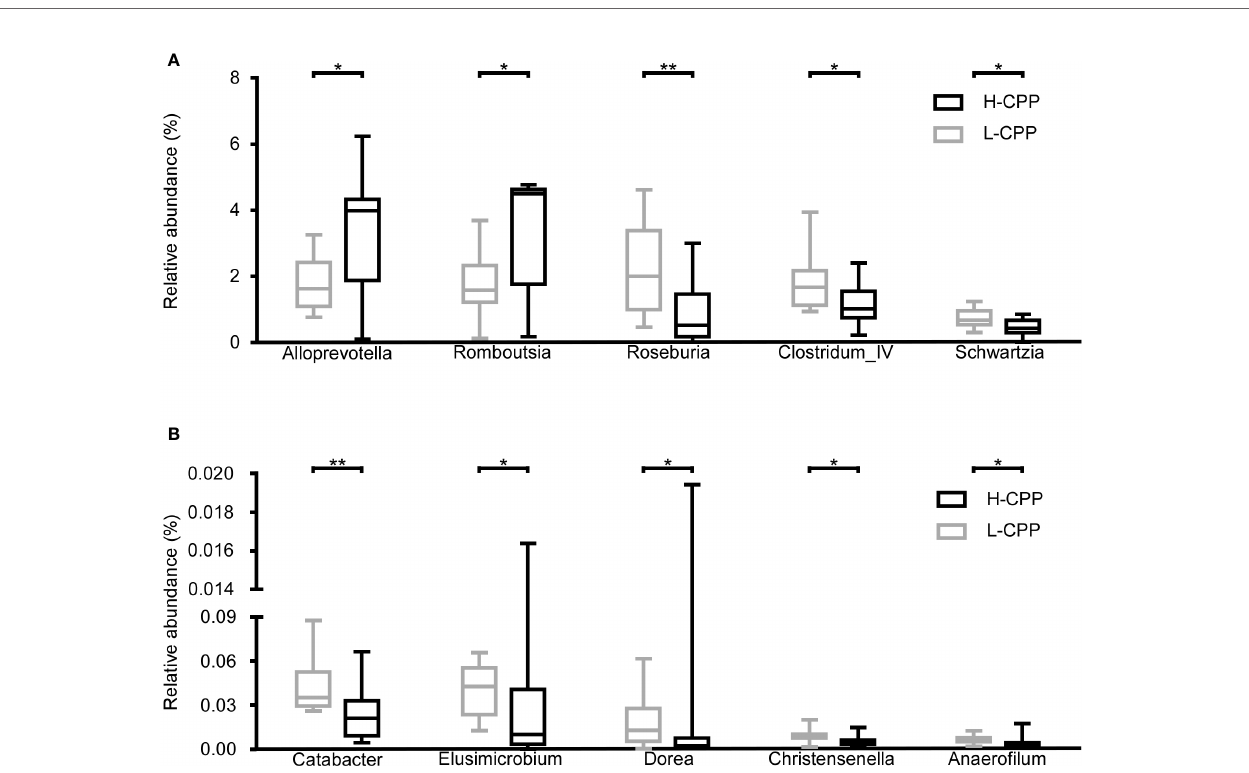
FIGURE 5 | Comparison of the gut microbiota composition between the low and high conditional place preference group (L-CPP versus H-CPP) after the morphine- induced CPP training. (A) The relative abundance of Alloprevotella , Romboutsia , Roseburia , Clostridium_IV and Schwartzia , were found to be different between L- CPP and HCPP. (B) The relative abundance of Catabacter , Elusimmicrobium , Dorea , Christensenella and Anaero fl ium were found to be different between L-CPP and H-CPP. A Mann-Whitney test was used to analyze the data. The central line shown in each box plot indicates the median of data. Whiskers extend to cover the whole range of values. A student ’ s t test was used for the data with Gaussian distribution. Statistical signi fi cance was accepted at p < 0.05. *p < 0.05; **p < 0.01; ***p < 0.001; ****p <